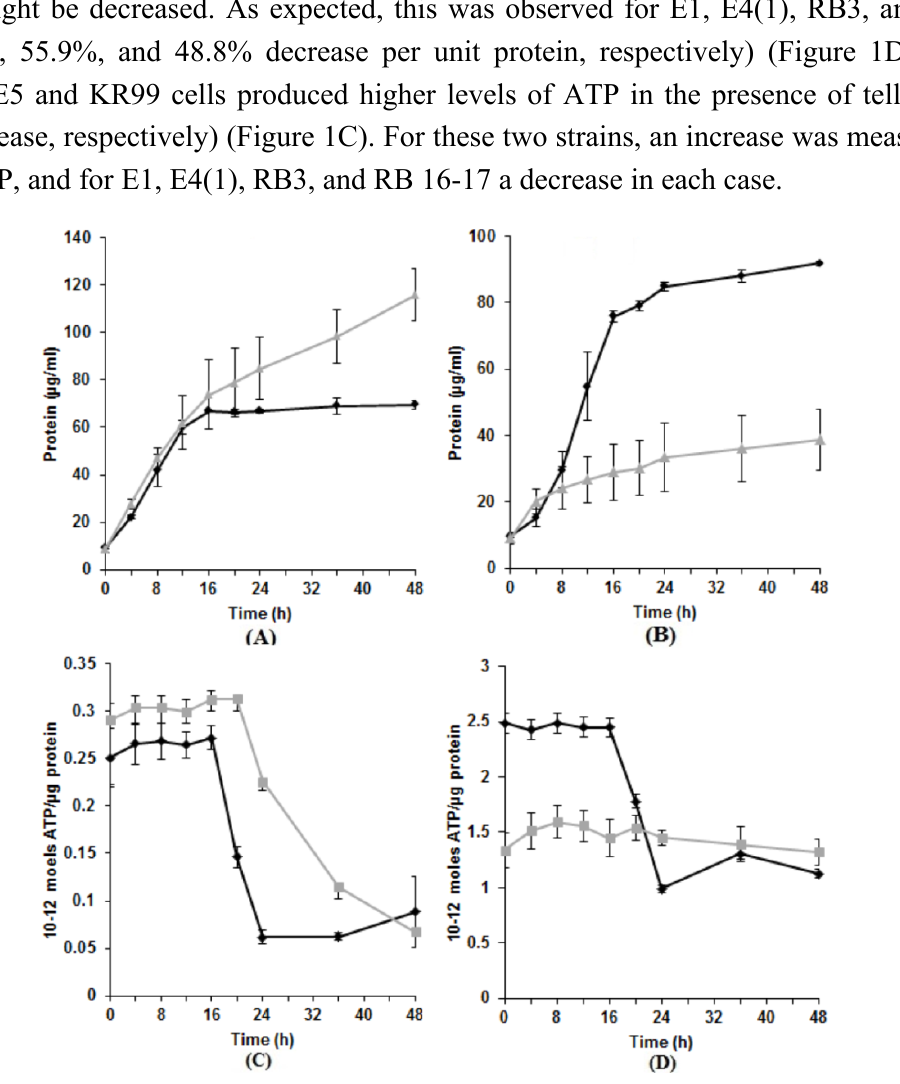
Figure 1. Protein and ATP production in the presence versus absence of K 2 TeO 3